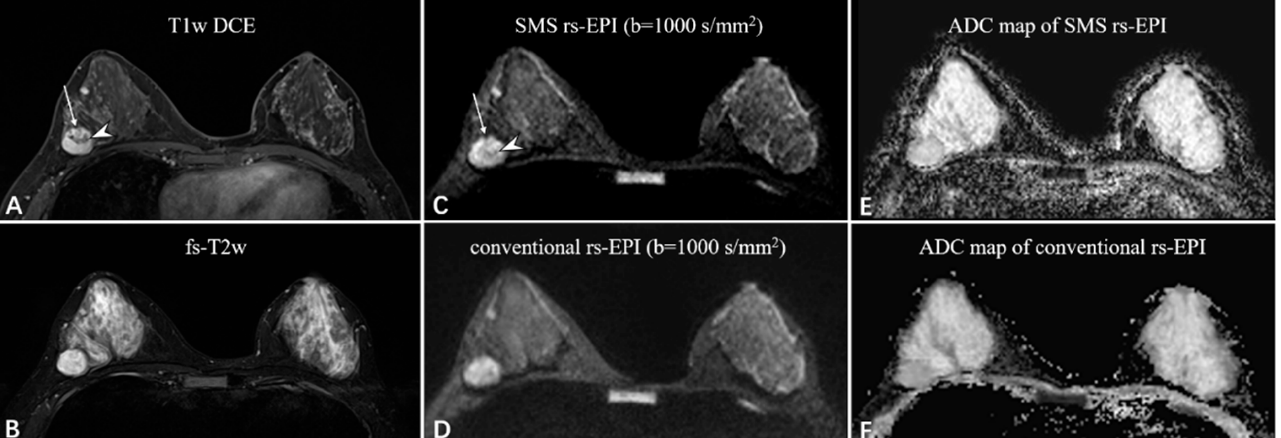
Figure 3. A 38-year-old woman with fibroadenoma in the right breast. The oval mass with slight lobulation (long white arrow) shows heterogeneous enhancement with dark internal septation (white arrowhead) on the T1-weighted DCE images ( A ) and strong high-signal intensity on the fat-saturated T2-weighted images ( B ). Compared to the rs-EPI image ( D ), the SMS rs-EPI image ( C ) shows better sharpness of anatomical details, in which the lobulated margin pointed by long white arrows and internal heterogeneous component pointed by white arrowheads are clearly shown. The lesion is more conspicuous with a clear margin and less distortion in the ADC map of SMS rs-EPI, although there is no ADC reduction due to the benign nature of the lesion ( E , F ).